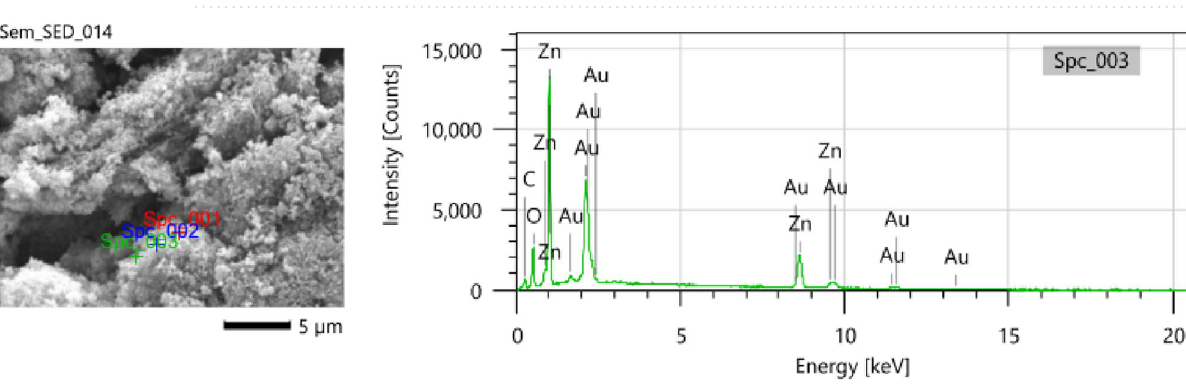
Figure 7. EDX analysis of PHBV/Ag–ZnO (5%) bionanocomposite. The Au peaks are due to the gold coating used for SEM sample preparation. Ag peaks are not visible, as Ag doping was constant at 1 mol% which is below the detection